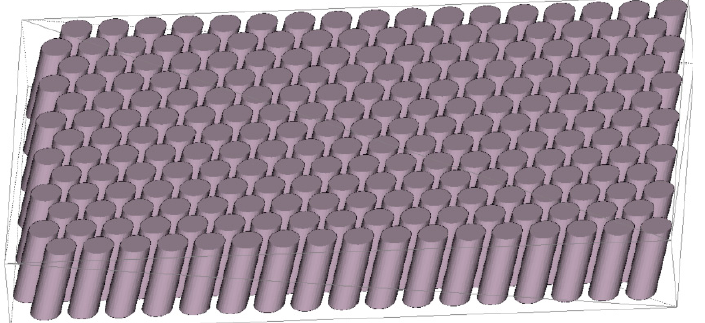
Figure 18. Arrangement of the CGx on BP_1_2-3 and 1_3-3.